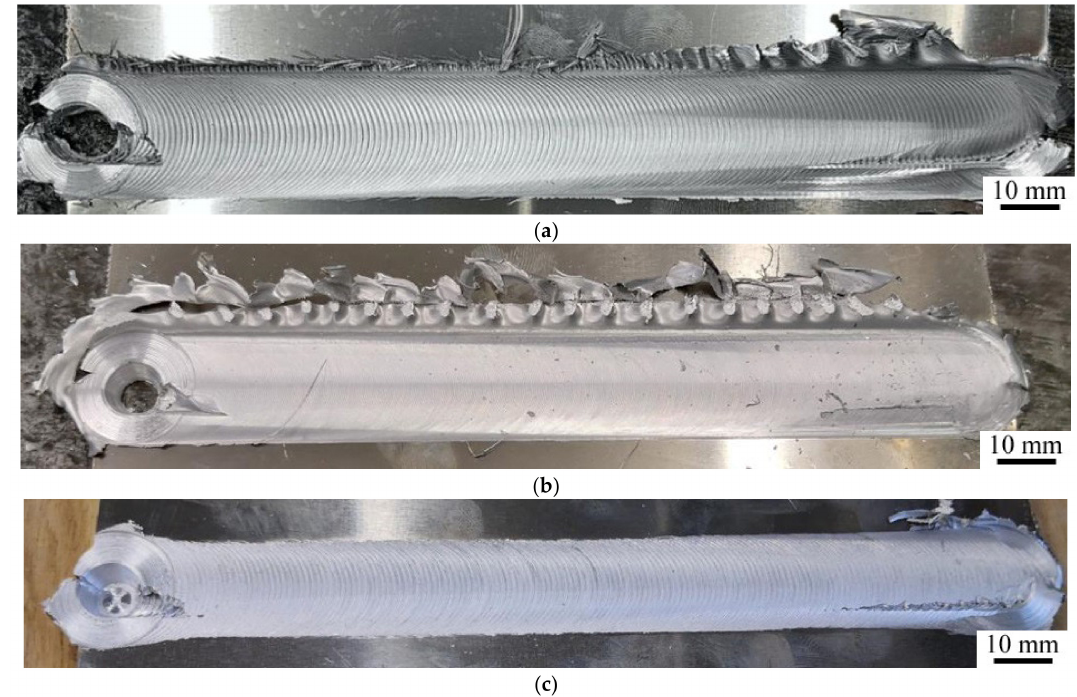
Figure 3. The FSW (Friction Stir Welding) joints: ( a ) CR6; ( b ) TR 1; ( c )